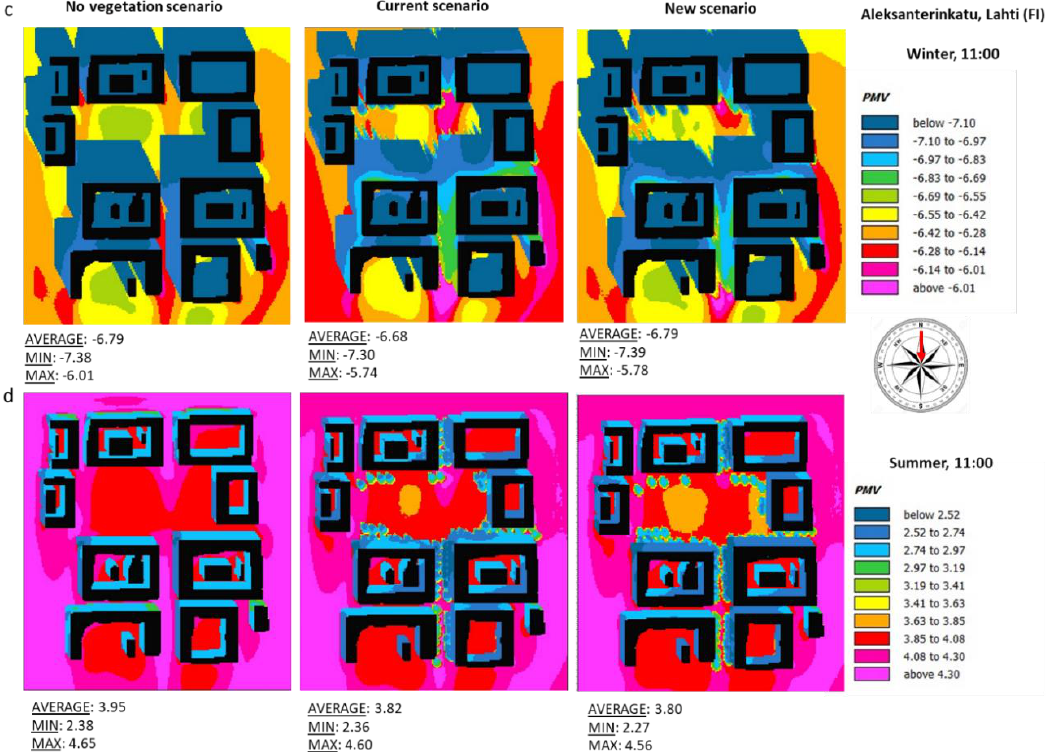
Figure 8. Spatial distribution of predicted mean vote (PMV) at 15:00 in San Pio ( a , b ) and at 11:00 in Aleksanterinkatu ( c , d ) at height of 1.4 m for the no vegetation scenario (left), current scenario (middle) and new scenario (right) in winter and summer days. Table 3. PMV values in San Pio and Aleksanterinkatu at the extraction points indicated in Figure 6.